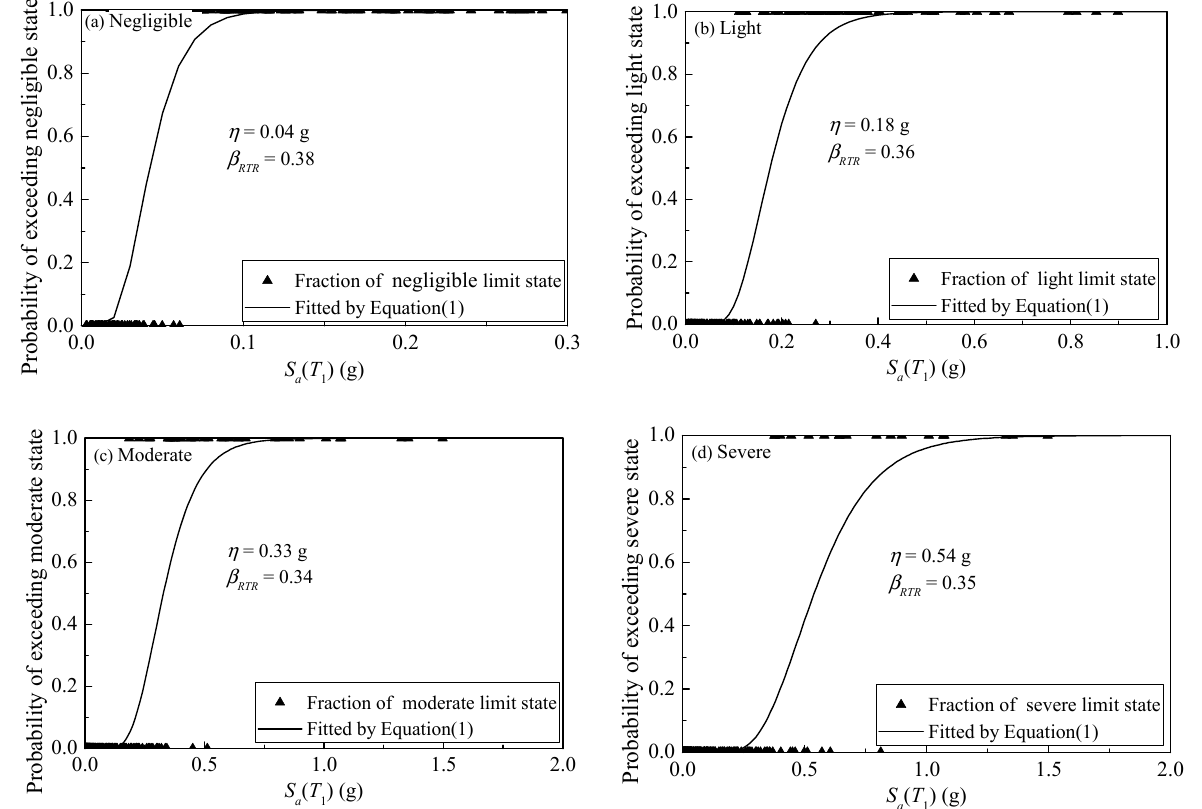
Figure 6. Fragility curves characterized by S a ( T 1 ) for the four damage limit states in cases of far-field set.